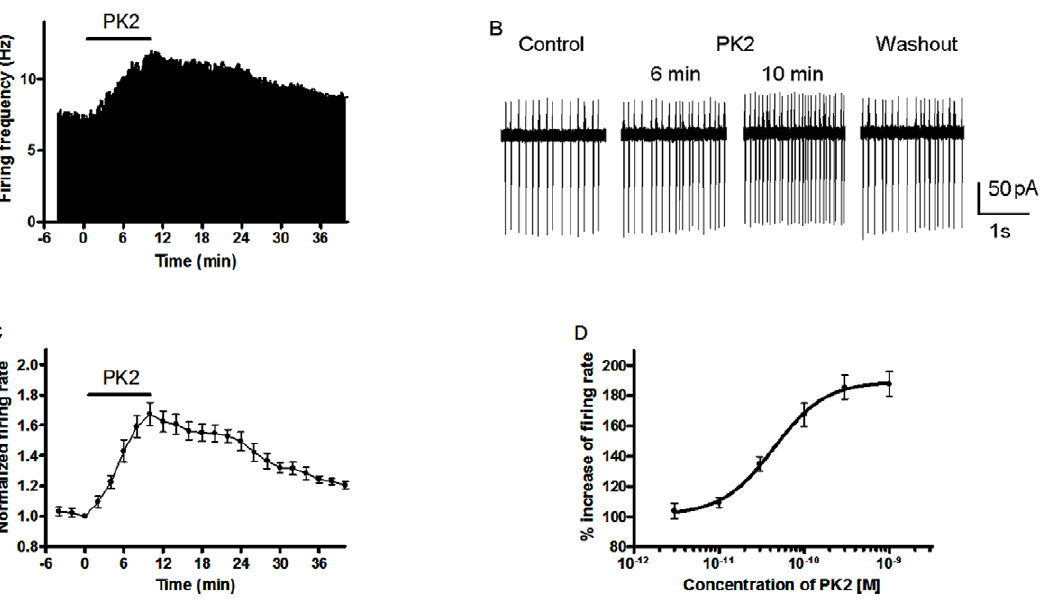
Figure 1. Effect of PK2 on spontaneous firing in suprachiasmatic nuclei (SCN) neurons. (A) Firing rate histogram showing an example of a neuron responding to PK2 (10 min treatment with 0.1 nM) with increased firing. (B) Representative traces of spontaneous activity from the cell with the cell-attached mode in (A). (C) Time course of change in spontaneous firing rate from eight cells exposed to 0.1 nM PK2 for the duration indicated by the length of the line. Data are represented as normalized mean 6 SEM. (D) Dose-response curve for the effect of PK2 on spontaneous firing rate. EC 50 was calculated to be 44.3 pM. Each point represents the normalized mean 6 SEM of 6–8 neurons. All firings were recorded in the dorsal division of SCN during daytime (ZT